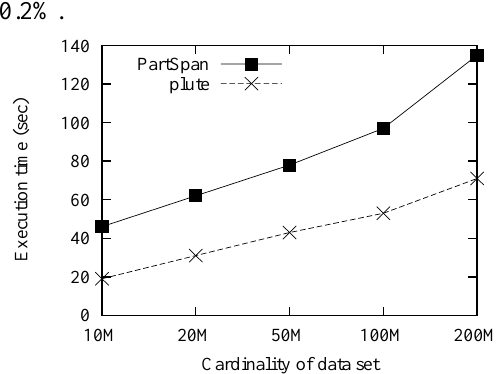
Fig. 7. Real data